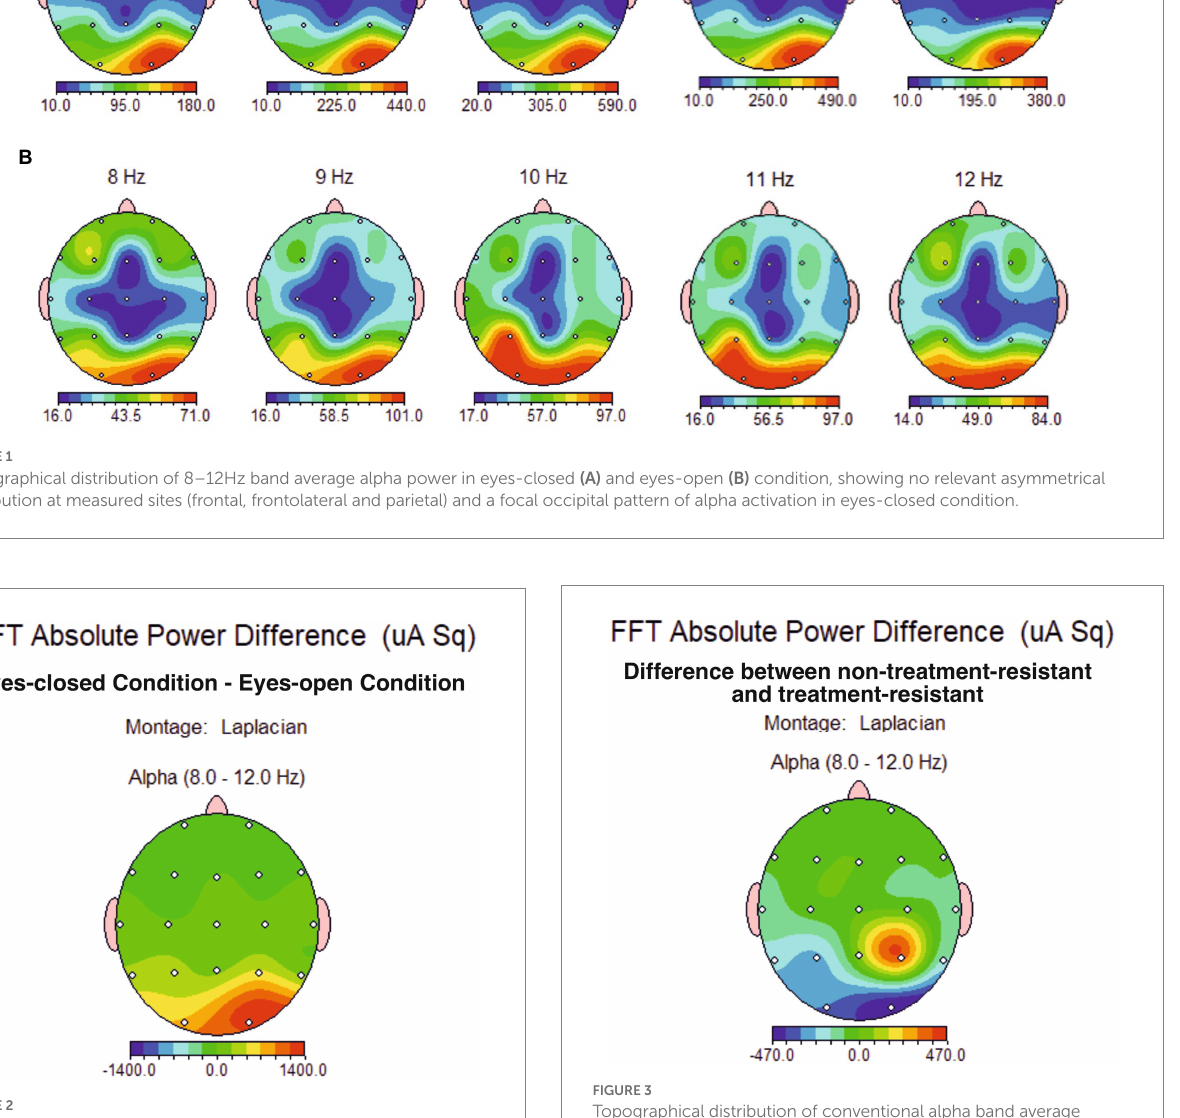
Across locations, there were no significant differences in alpha asymmetry between the eyes-open condition, M = 16.06, SD = 56.05, and the eyes-closed condition, M = 13.78, SD = 59.15, F (1, 23) = 0.09, p = 0.767, η 2 G < 0.001 (Figure 7). There were no significant differences in alpha asymmetry between conditions depending on location, F (1.81, 41.55) = 1.48, p = 0.240, η 2 G = 0.008.